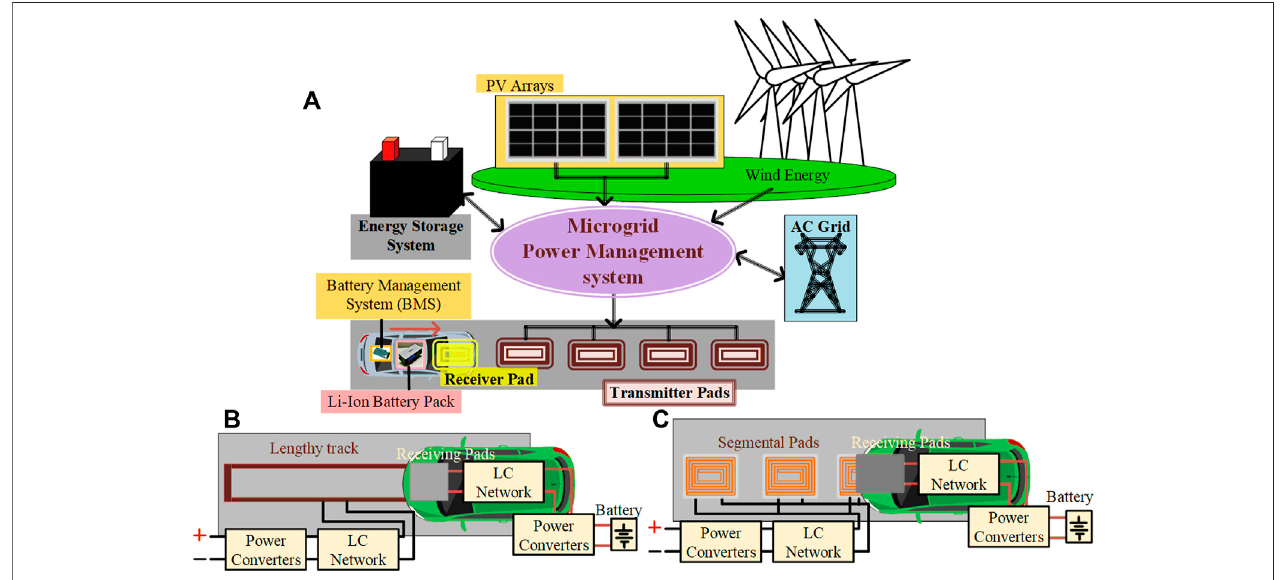
Figure 2A . The energy resources for the DWC system are AC